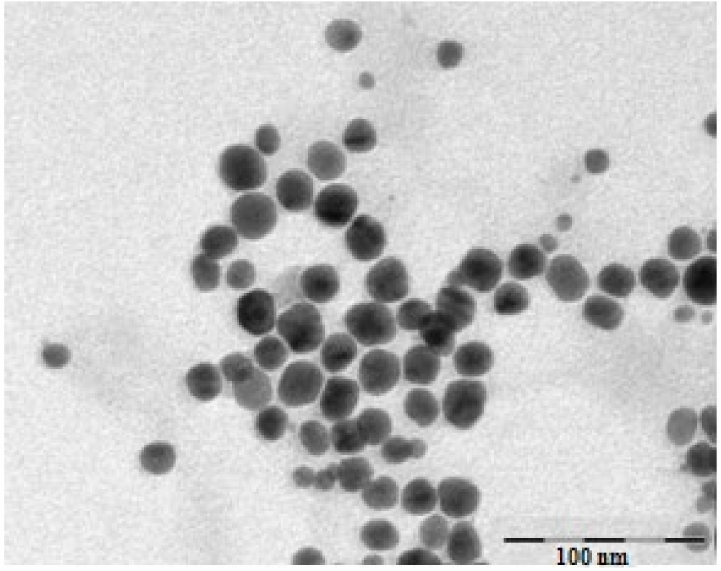
Figure 3. TEM image of obtained gold